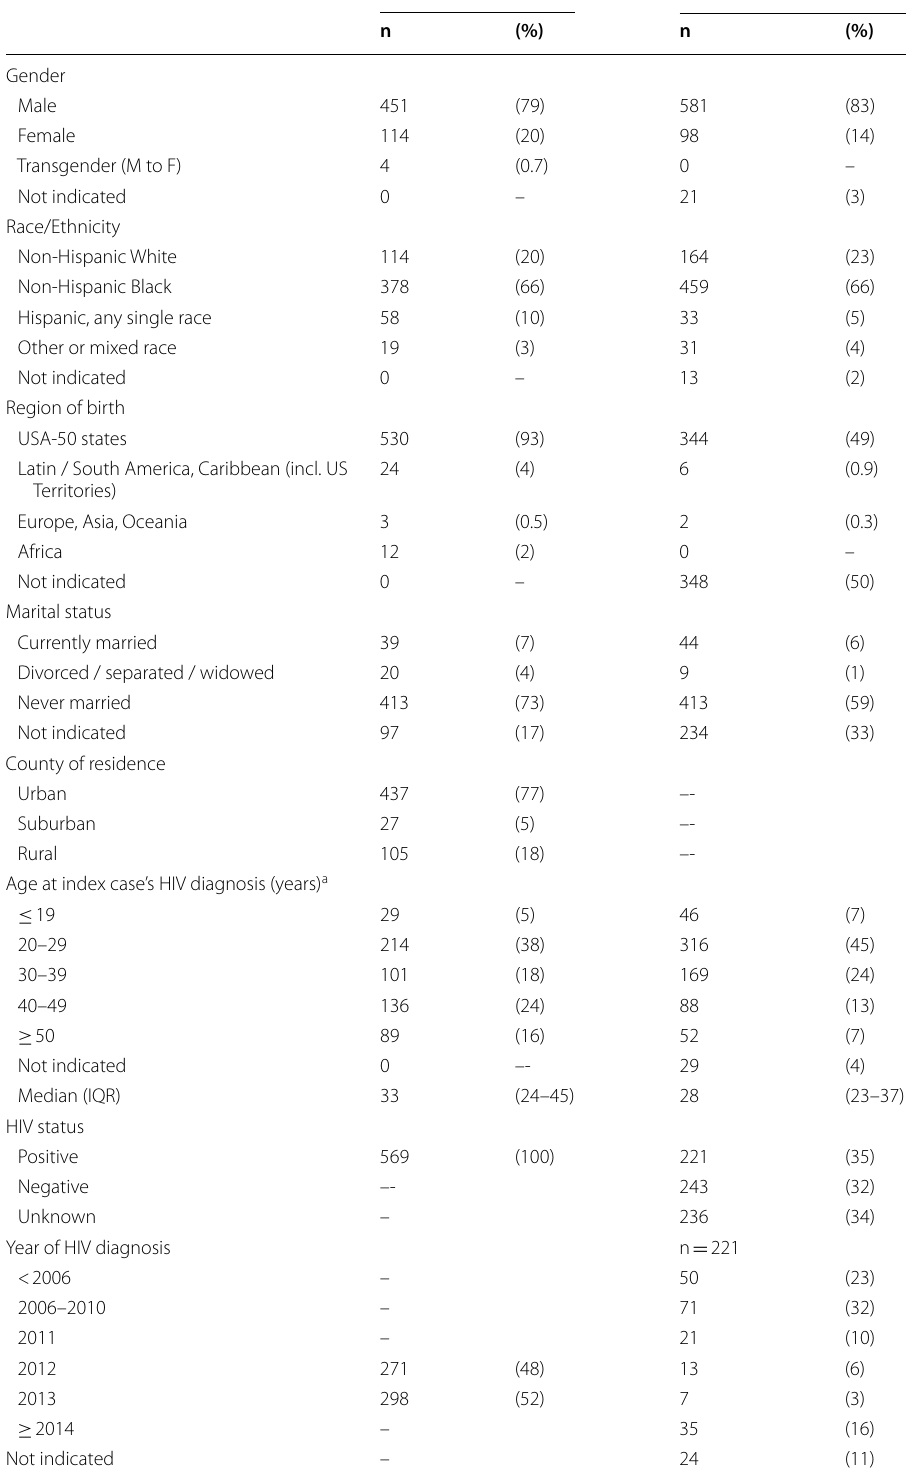
Table 1 Index HIV cases aged 14 years and older diagnosed 2012–2013 in NC HIV/STD Control Region 6 and their disclosed and traced first-degree contacts in the sociosexual network (N =